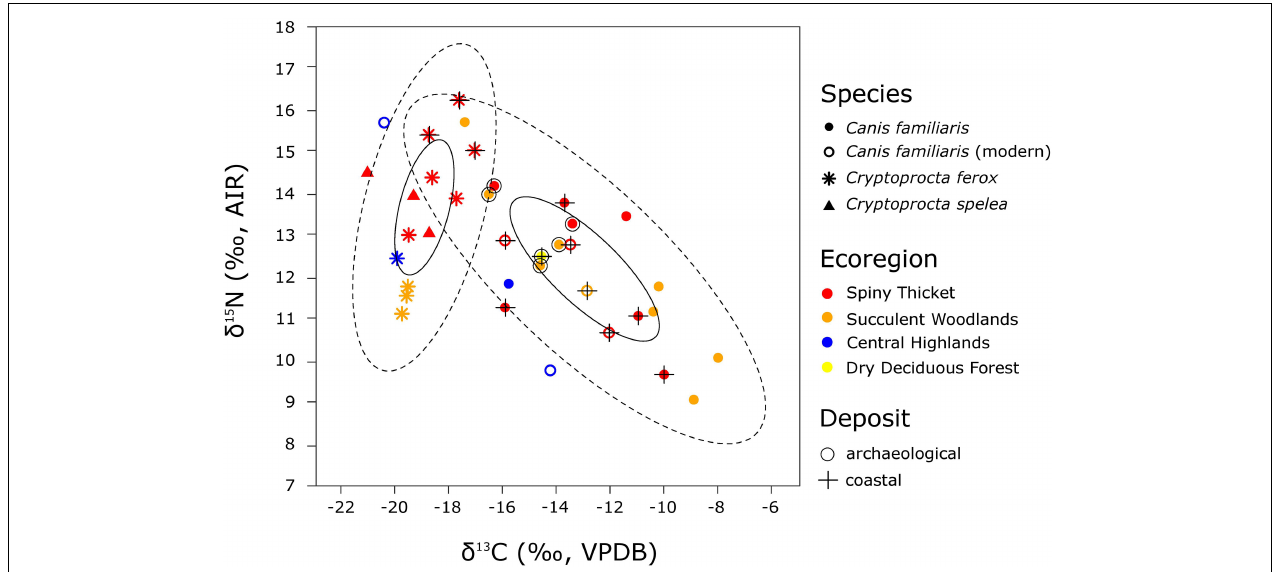
FIGURE 6 | Stable carbon and nitrogen isotope data for bone collagen from dogs (both modern and subfossil) and members of Cryptoprocta (all subfossil), with points colored according to ecoregion, shaped according to taxon, and marked according to deposit type ( n = 36). For each genus, ellipses outline approximately 95% of the data (dashed) and 40% of the data (solid) from only the SW ecoregions (spiny thicket and succulent woodlands, Canis n = 19, Cryptoprocta n = 12). Island-wide, average calibrated dates for C. spelea specimens ( n = 3) range from 3,280 to 1,760 cal BP, those for C. ferox ( n = 10) range from 2,900 to 1,010 cal BP, and those for dogs ( n = 23) span from 890 cal BP to the present. The six modern dogs have δ 13 C values that are corrected for the Suess Effect (following Crowley and Godfrey, 2013) so that they are comparable with subfossil collagen